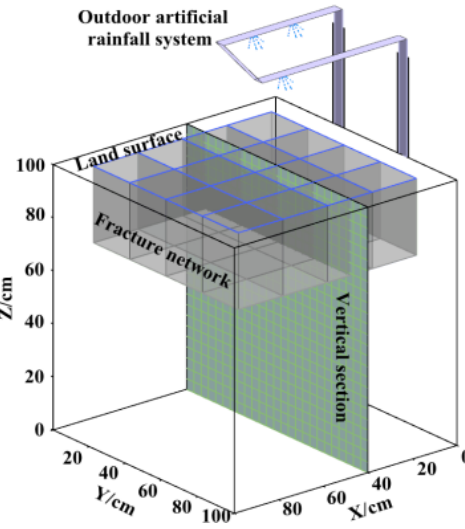
which does bleach the complex color of the formed starch–iodide. In addition, the effect of dissolving starch in the I − solution was better than applying starch powder directly to the soil profile, avoiding a wetting process in the starch layer caused by the I − solution in the soil. The indication solution consisted of 50 g/L of starch and 0.05 M of iron (III) nitrate (Fe(NO 3 ) 3 ). The indication solution was added with a pressurized sprayer that released a continuous and fine mist made up of an indication solution. The indication solution was sprayed on the surface as uniformly as possible with long, slow strokes. After spraying, it took about 10 min for a dark blue-violet color to develop in the flow zone as a result of the iron (III) nitrate oxidizer. We photographed the experiment section and measured the soil moisture content. The soil samples were collected as described above.